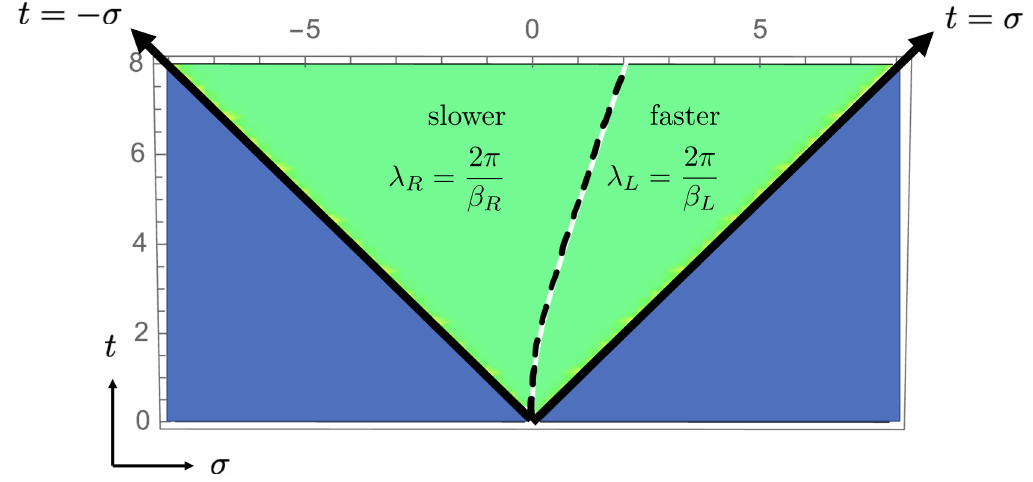
. The plot was obtained Ω , c = 10 , h w = 5 and h v = 1 . 5 . 3